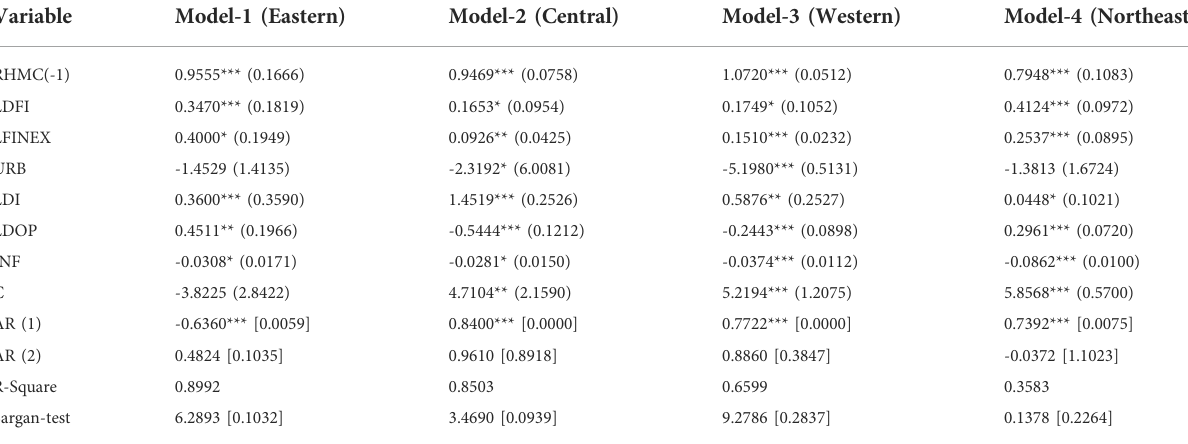
TABLE 8 Results of systematic GMM estimation of the Total Digital Inclusion Index on rural human capital accumulation in different regions.